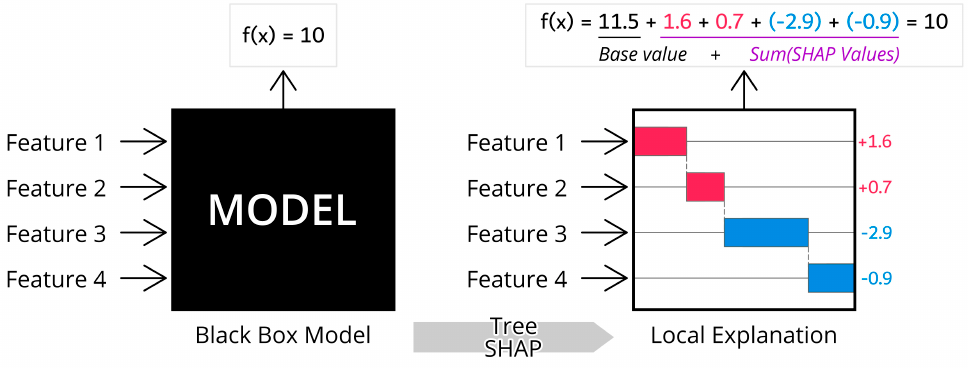
Figure 3. TreeSHAP